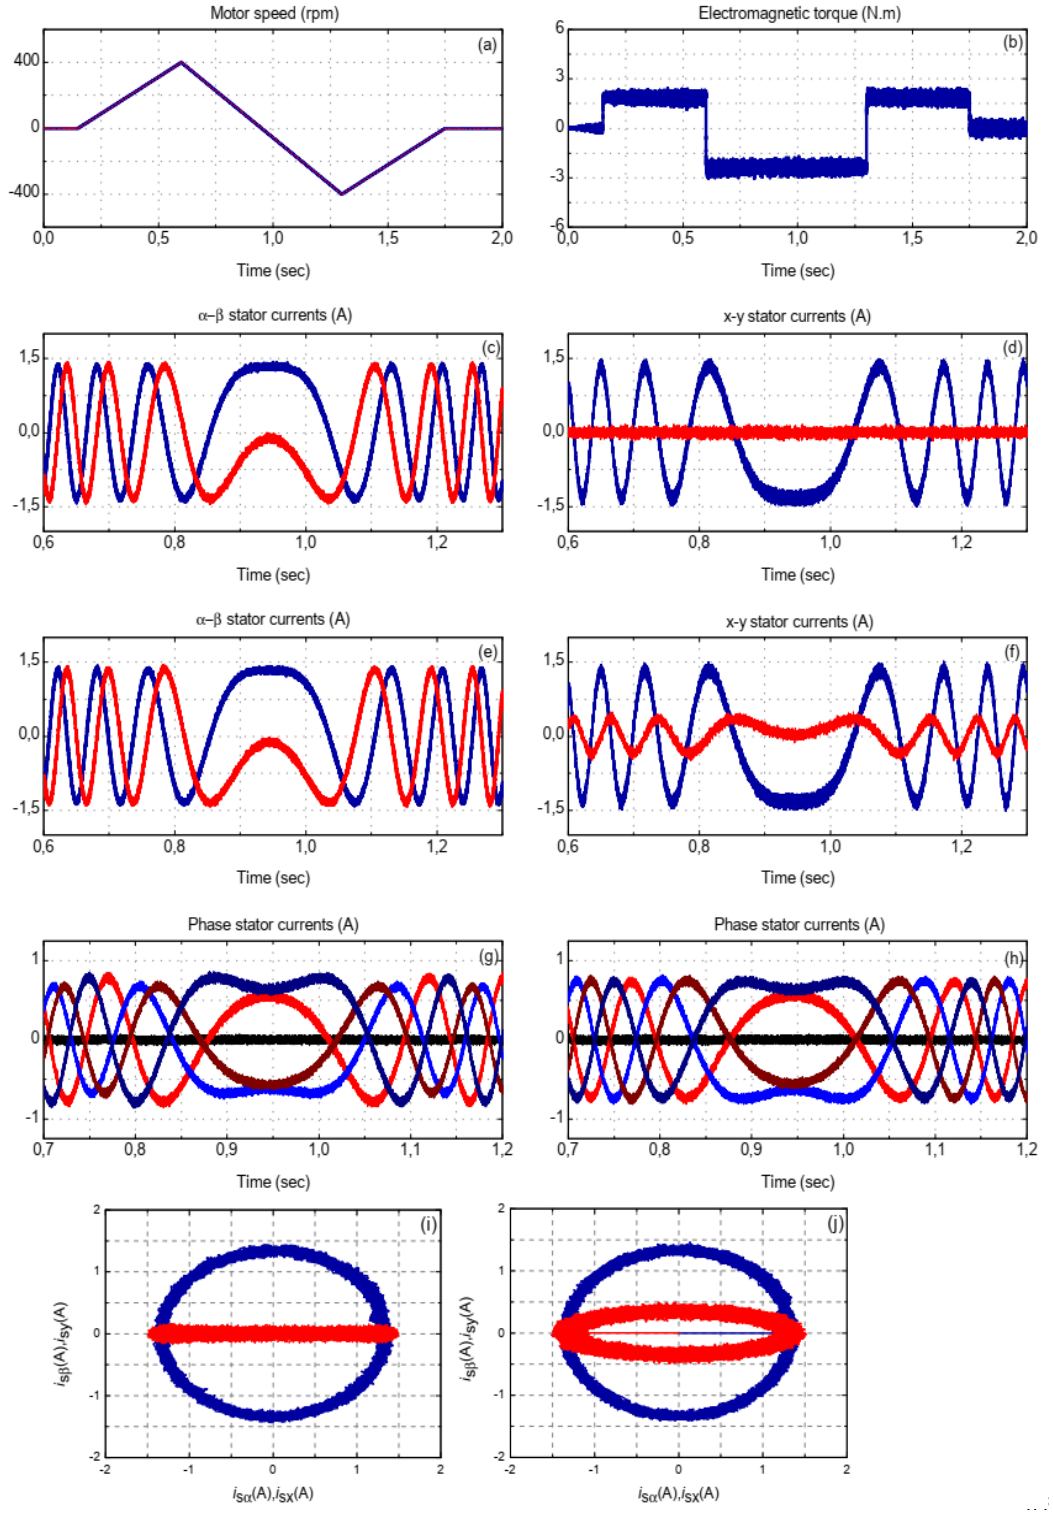
Figure 8. Simulation results of hysteresis controller ( a ) motor speed, ( b ) electromagnetic torque, ( c ) α – β stator currents minimum losses (ML), ( d ) x – y stator currents ML, ( e ) α – β stator currents minimum derating (MD), ( f ) α – β stator currents MD, ( g ) phase stator currents ML, ( h ) phase stator currents MD, ( i ) current trajectories in the α – β plane ML, ( j ) current trajectories in the x – y plane